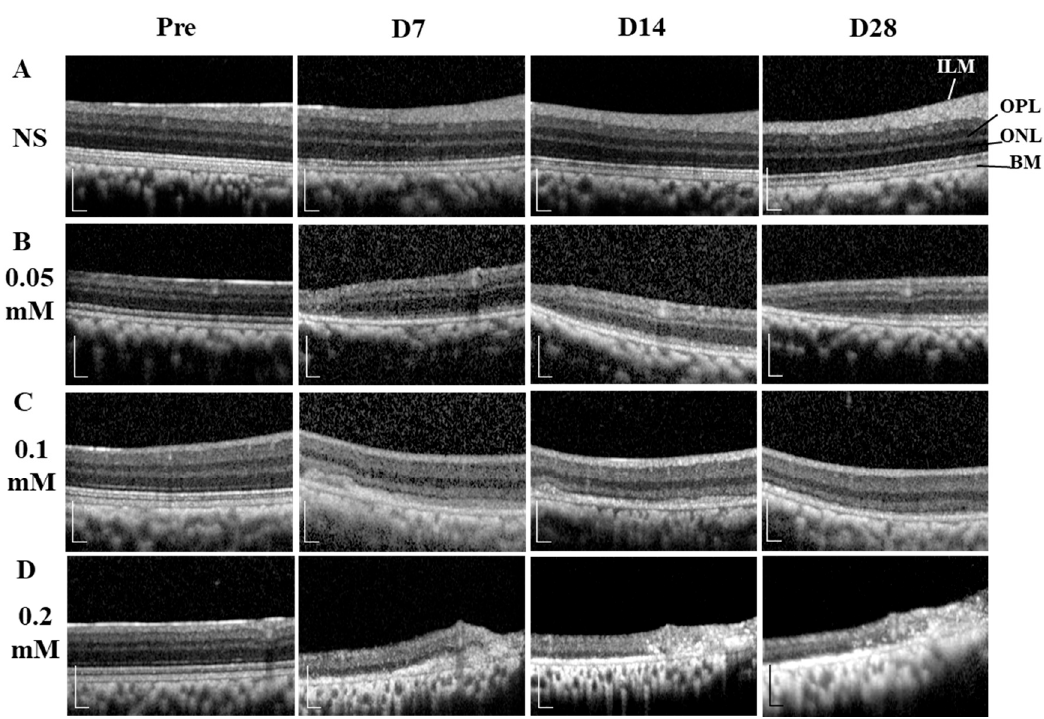
Figure 3. SD-OCT images showing the dynamic changes of retinal structures within 28 days after SNP treatment. ( A ) NS, ( B ) 0.05 mM SNP, ( C ) 0.1 mM SNP, ( D ) 0.2 mM SNP. ILM: internal limiting membrane; OPL: outer plexiform layer; ONL: outer nuclear layer; BM: Bruch’s membrane. Scale bar: 200 μ M.